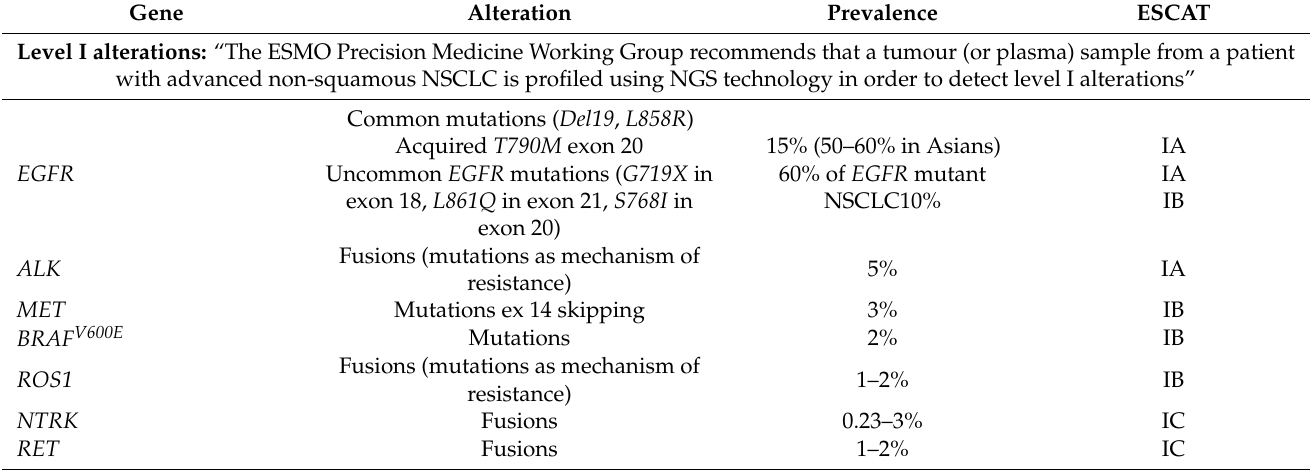
Table 1. ESMO Precision Medicine Working Group recommendations for NGS in non-squamous NSCLC. Gene Alteration Prevalence